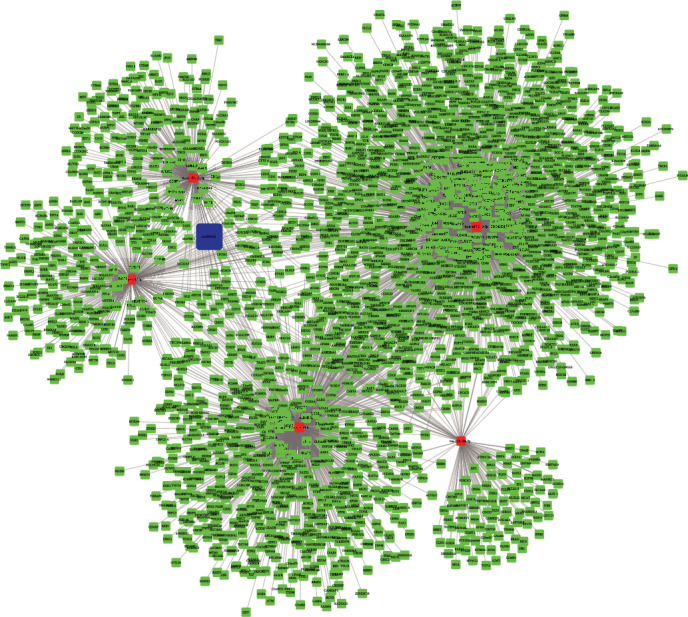
Construction of circEIF4G2-mediated ceRNA networks in OS. A total of 5 miRNAs (hsa-miR-218-5p, hsa-miR-188-5p, hsa-miR-4465, hsa-miR-517-5p, and hsa-miR-525-5p) and 2187 mRNAs were included in the circEIF4G2-mediated ceRNA network in OS.